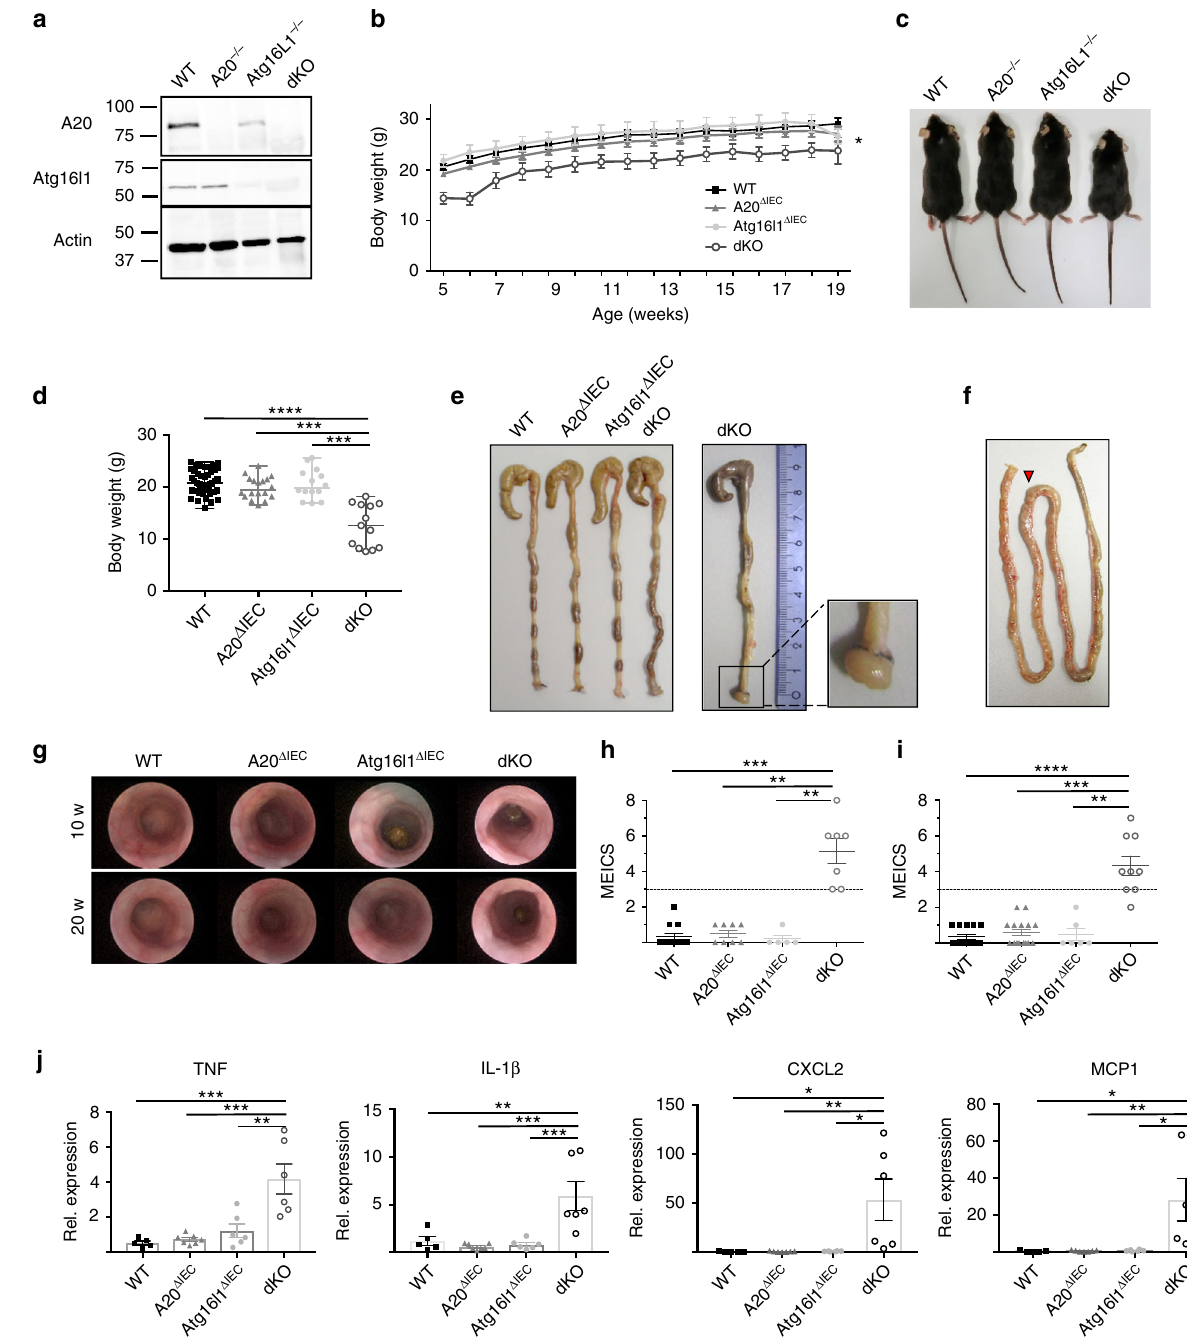
Fig. 5 IEC-speci fi c A20/Atg16l1 de fi cient mice develop spontaneous intestinal pathology. a Representative Western blot analysis of small intestinal organoid cultures from wild-type (WT), A20 Δ IEC , Atg16l1 Δ IEC , and A20/Atg16l1 dKO mice. b Absolute body weight in grams of WT ( n = 18), A20 Δ IEC ( n = 10), Atg16l1 Δ IEC ( n = 7), and littermate A20/Atg16l1 dKO ( n = 8) mice in function of time. Data are expressed as mean ± SEM. * p < 0.05 for dKO mice compared to the three control groups, as analysed as repeated measurements using the residual maximum likelihood as implemented in Genstat v17. c Representative picture of 20-week-old littermate WT, A20 Δ IEC , Atg16l1 Δ IEC , and A20/Atg16l1 dKO mice. d Body weight of WT, A20 Δ IEC , Atg16l1 Δ IEC , and A20/Atg16l1 dKO mice at the age of 5 weeks. Each symbol represents one mouse. Data represent mean±SEM. **** p < 0.0001; *** p < 0.001, as analyzed in GraphPad Prism 7 with Kruskal-Wallis test. e Representative macroscopic colon images of 20-week-old WT, A20 Δ IEC , Atg16l1 Δ IEC , and dKO littermate mice showing rectal prolapses and colon thickening in dKO animals. f Representative macroscopic image of the small intestine of a 20-week-old dKO mouse showing increased vascularization and swelling in the jejunum (red arrow head). g Representative endoscopic pictures of 10-week old WT, A20 Δ IEC , Atg16l1 Δ IEC , and dKO mice demonstrating spontaneous colon pathology in dKO mice. h , i Colon in fl ammation detected by endoscopy and represented as mouse endoscopic index of colitis severity (MEICS) score in 10-week-old ( h ) and 20-week-old ( i ) WT, A20 Δ IEC , Atg16l1 Δ IEC , and dKO mice. Each symbol represents one mouse. Data represent mean±SEM. **** p < 0.0001; *** p < 0.001; ** p < 0.01, as analyzed in GraphPad Prism 7 with Kruskal-Wallis test. j Quantitative PCR for TNF, IL-1 β , CXCL2, and MCP1 in small intestinal lysates from WT, A20 Δ IEC , Atg16l1 Δ IEC , and dKO mice. Each symbol represents one mouse. Data represent mean±SEM. *** p < 0.001; ** p < 0.01; * p < 0.05, as analysed in GraphPad Prism 7 with One-way